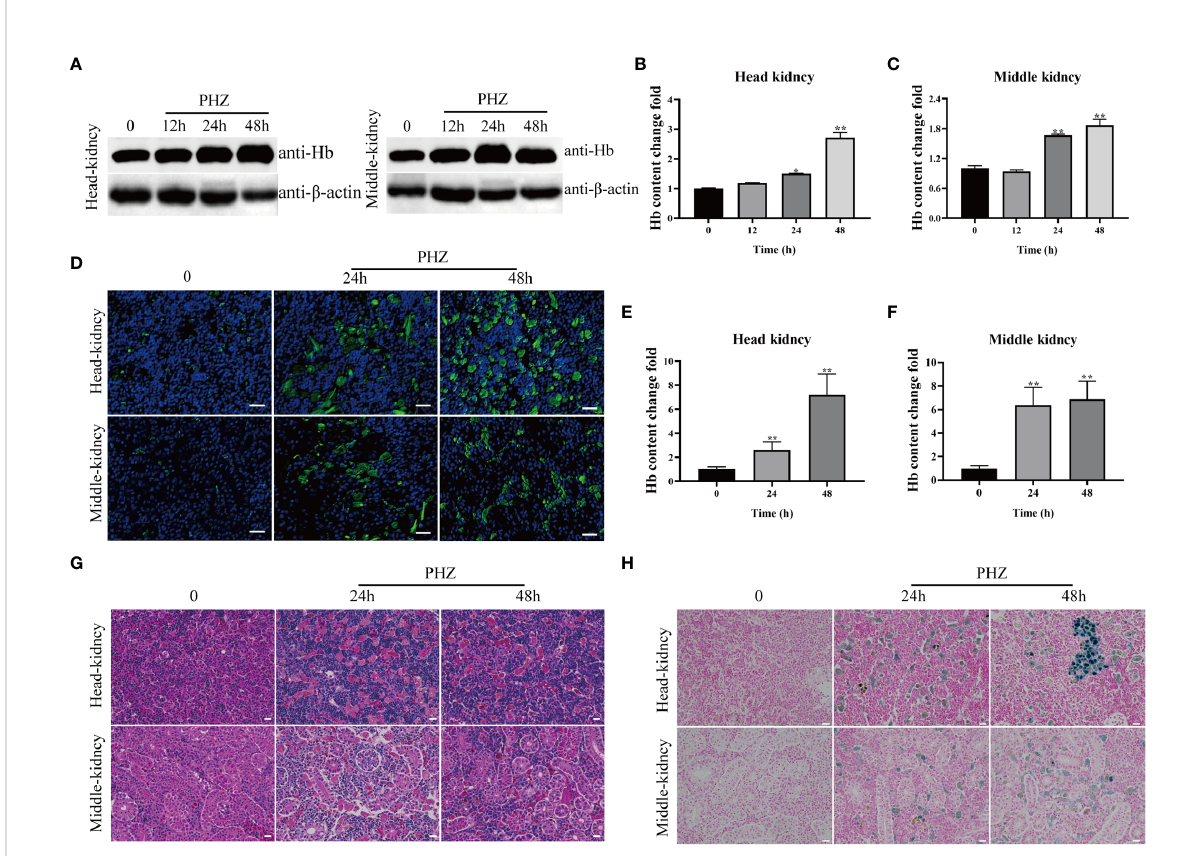
FIGURE 1 Hemolysis caused Hb accumulation and tissue injury. (A – C) WB was used to analyze the accumulation of Hb in head and middle kidney after injection of PHZ for 12 h, 24 h and 48 h and the corresponding grey ratios of Hb were analysed by image J. (D) The accumulation of Hb in head and middle kidney were determined by IFA assay after injection of PHZ for 24 h and 48 h, the scale bar represents 20 m m. (E, F) The content of Hb in head (E) and middle kidney (F) after injection of PHZ for 24 h and 48 h. (G) The head and middle kidney were stained with hematoxylin- eosin staining at 24 h and 48 h after injection of PHZ, the scale bar represents 20 m m. (H) Prussian blue stained head and middle kidney at 24 h, and 48 h after PHZ injection, the scale bar represents 20 m m.*P<0.05; **P< 0.01 (Student ’ s t-test). The data were the mean values of three independent experiments, expressed as mean ± SEM(*P < 0.05, **P <